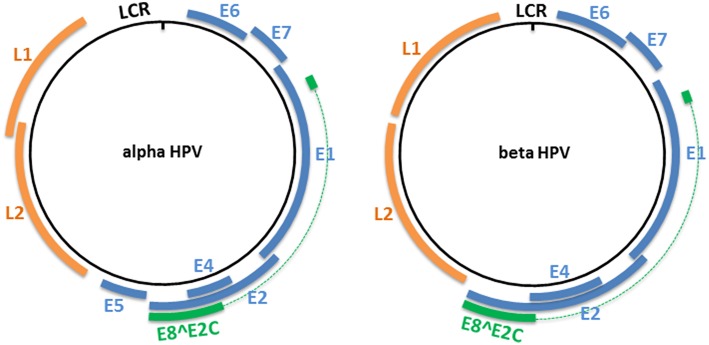
Genome organization of alpha and beta HPV types. The circular dsDNA genome of high-risk alpha and beta HPV types is represented by a black circle. The positions of the early and late genes are represented by blue and orange, respectively. Both represented PV genera have the potential to express an E8∧E2C transcript that encodes for a protein that includes an E8 domain fused to the hinge and DNA-binding domains of E2. LCR, long control region.